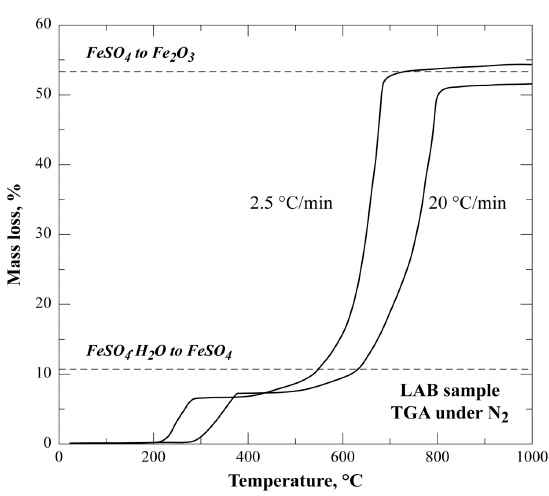
Figure 5. TG analysis in N 2 of the LAB sample.